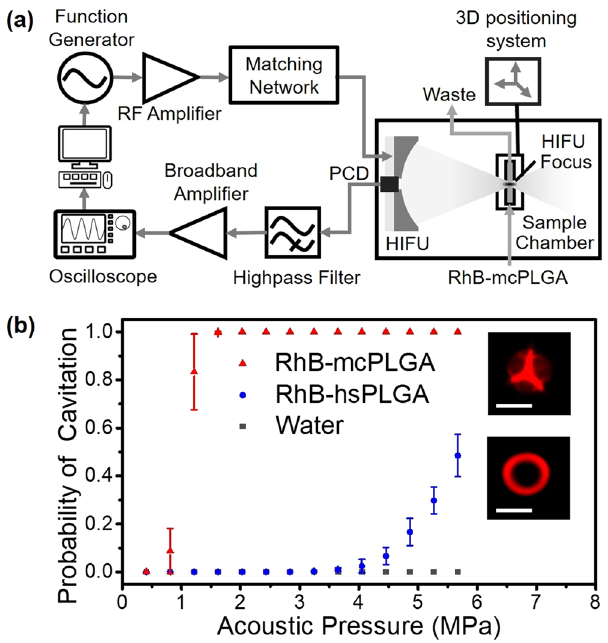
Figure 5. ( a ) Schematic of the HIFU setup. ( b ) Probability of cavitation of water, spherical PLGA particles, and RhB-mcPLGA MPs exposed to HIFU at 1.1 MHz. ( Inset ) Fluorescence images of representative RhB-mcPLGA MPs and RhB-hsPLGA MPs. The scale bars represent 1 μ m. The points are an average and standard deviation of 3 independent